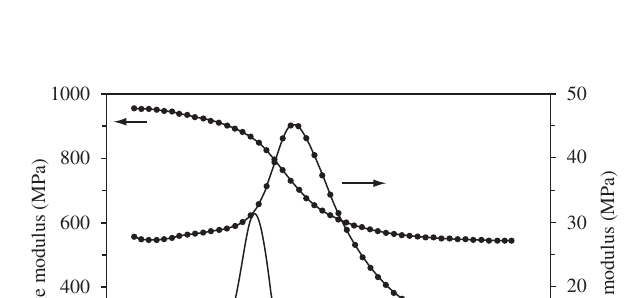
Figure 5. Residual porosity in a) a Haversian canal and b) in its surroundings.